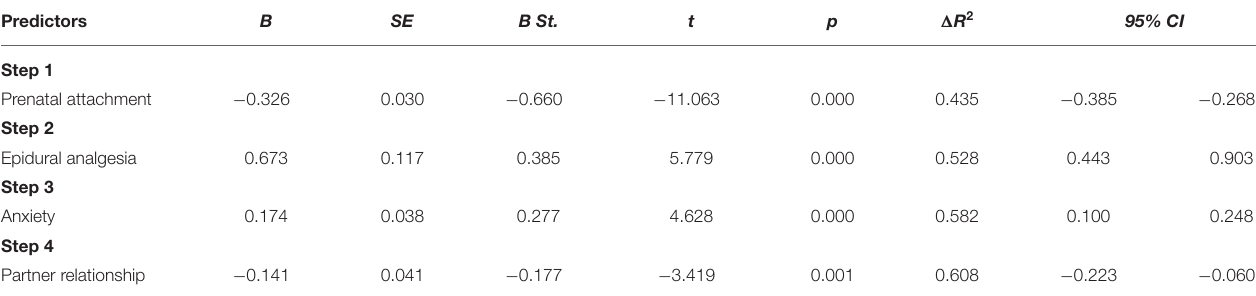
TABLE 5 | Summary of the linear regression analysis using stepwise method with all risk significant factors as independent variables for PPD score.